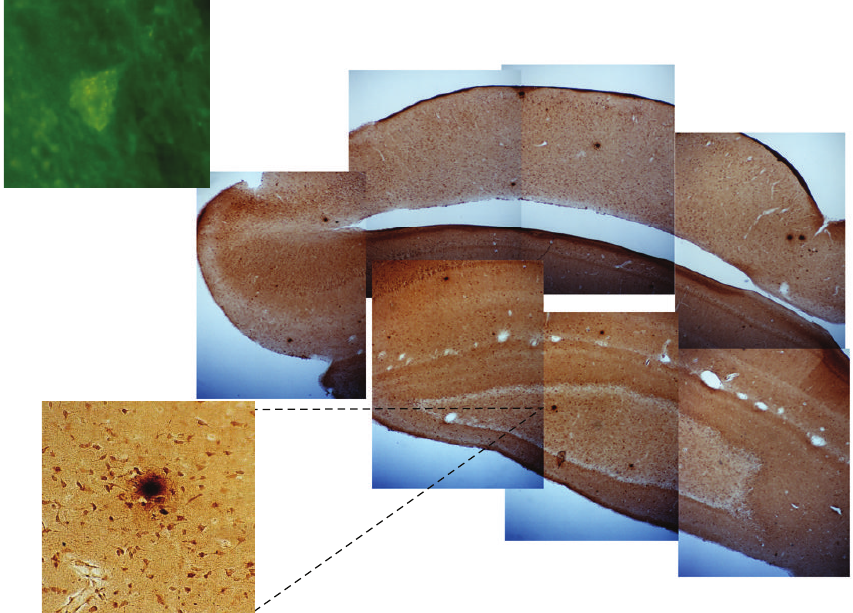
Figure 1: Photo montage of temporal lobe and hippocampus for a cholesterol-fed rabbit given distilled water supplemented with 0.12 parts per million copper as copper sulfate (right). Note the numerous dark spots that appear to be plaque-like structures that are shown in detail at bottom left. The top left image shows a thioflavin-S stained neuron from a cholesterol-fed rabbit given distilled water supplemented with 0.12 parts per million